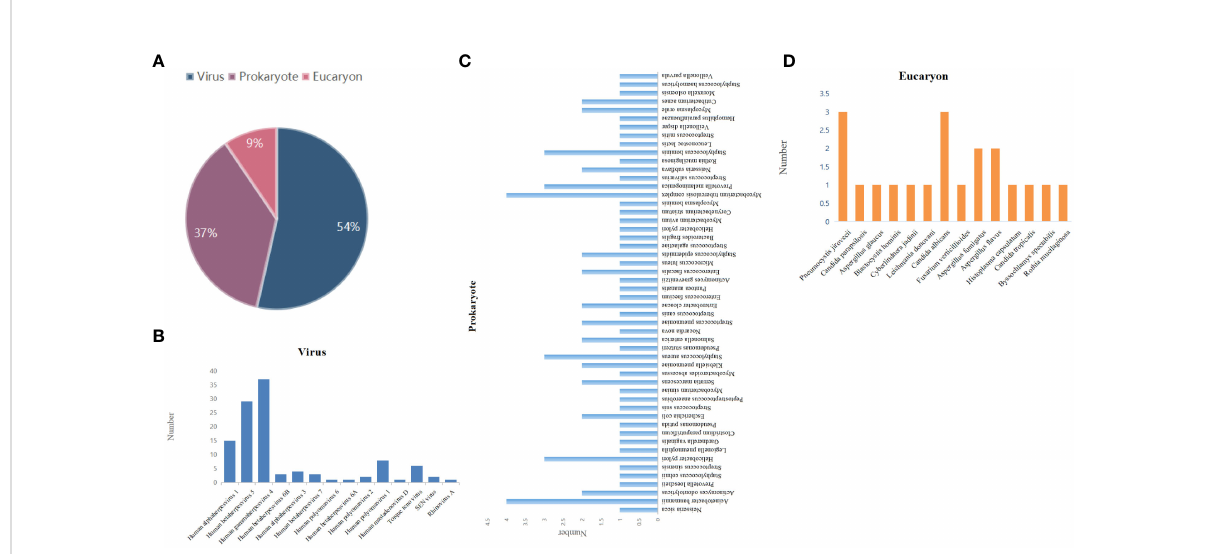
FIGURE 2 Distribution of pathogens detected by mNGS. (A) Type distribution of pathogens identi fi ed by mNGS. Species distribution of (B) viruses, (C) prokaryotes, and (D) eukaryotes detected by